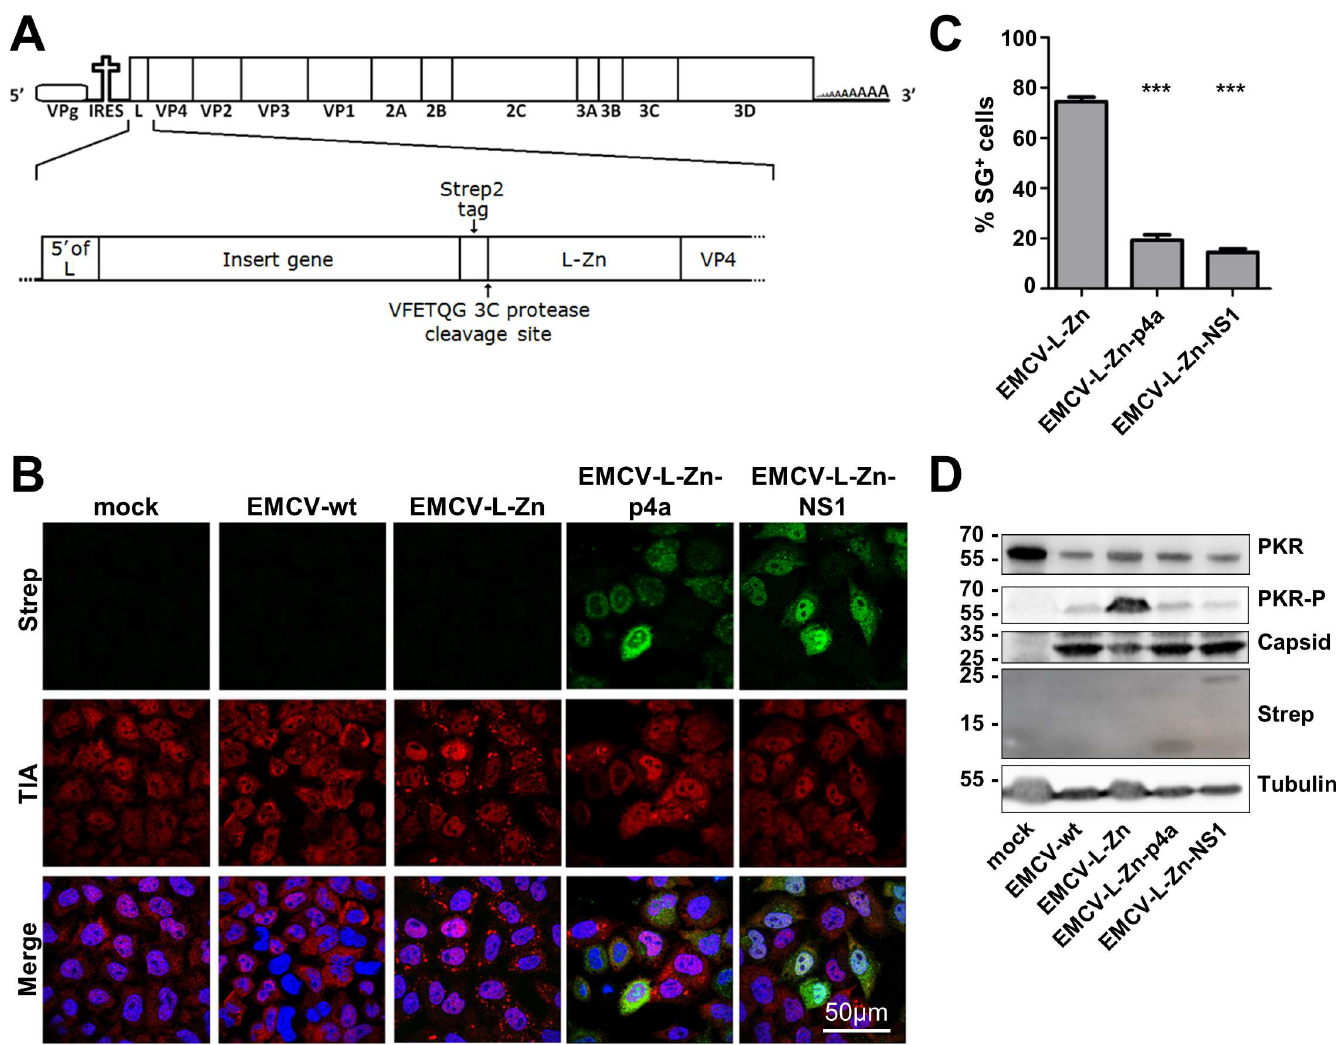
Fig 5. MERS-CoV p4a inhibits PKR activation during mengovirus infection. (A) Schematic overviewof the recombinantmengovirussystem. The upper panel shows the wt mengovirusgenome. The lower panel highlights the 5’-regionshowingthe gene insertion upstream of the inactivated L. (B) Immune fluorescence images of HeLa-wt cells that were mock-infected or infected with wt mengovirus or the indicatedrecombinant mengoviruses (MOI = 10). Cells were fixed at 6h post infection and stained for TIA1 (shown in red) and Strep-tagged p4a or NS1 (shown in green). Nuclei were stained using Hoechst-33258 (shown in blue). (C) SG-positive cells were quantifiedfrom three randomly selected images. Shown are means with standard deviations, which were analyzedusing an unpairedt-test ( *** , p < 0.001). (D) Western blot analysis of PKR and phospho-PKR in cells infected with indicated viruses. Capsid staining was used as a control for virus replicationefficiency, tubulin staining was used as loadingcontrol and Strep-tag staining showed expression of the MERS-CoV p4a and IAV